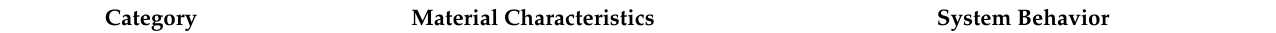
Table 3. Proposed classification system for smart materials and intelligent components [41], adapted from Schwartz,